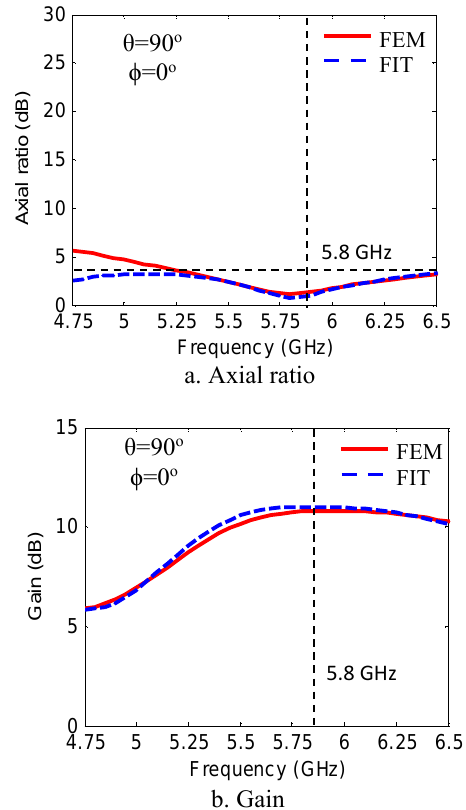
Fig.12. The axial ratio and gain of the 2×2 circularly polarized DRA array elements mounted on a cylindrical ground plane in free space.